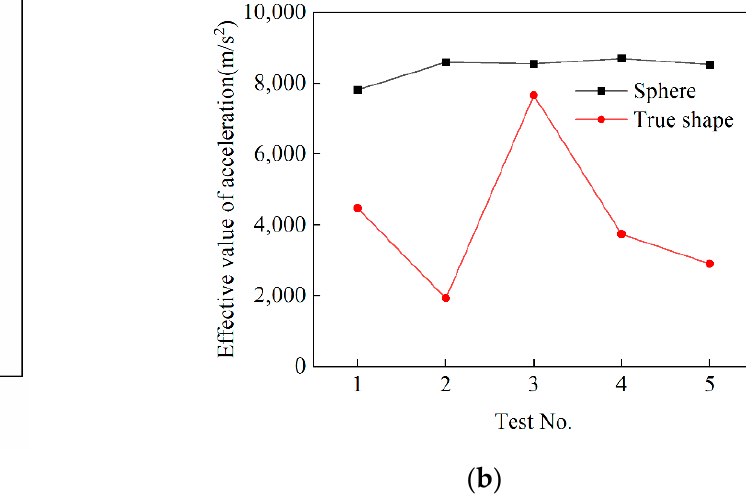
Figure 5. ( a ) Velocity responses caused by true shape and spherical coal. ( b ) Acceleration responses caused by true shape and spherical coal.